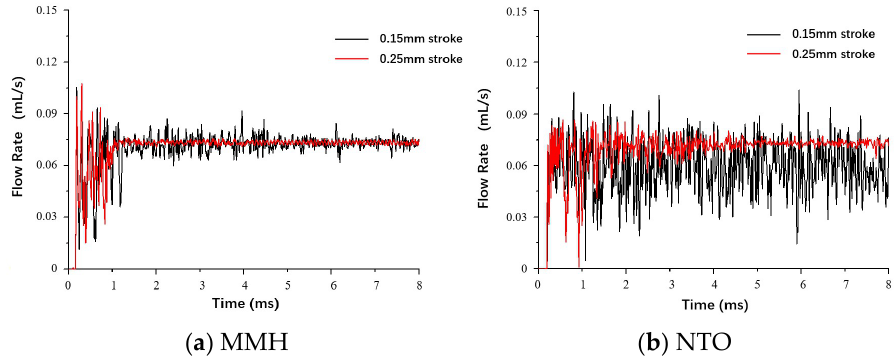
Figure 10. Comparison of MMH ( a ) and NTO ( b ) flowrate fluctuation under different switch speeds,